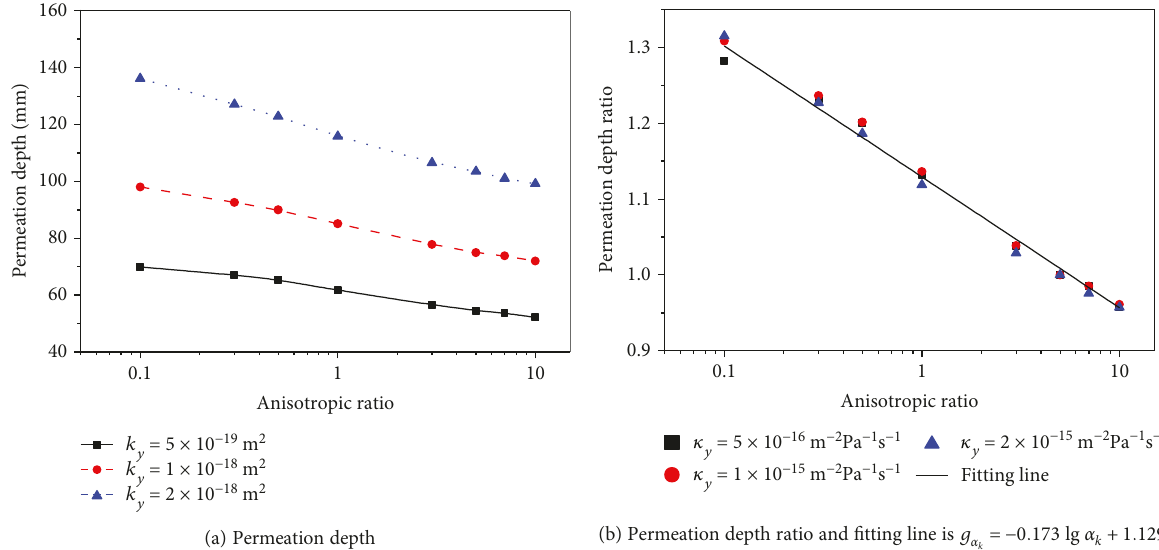
Figure 10: Changes of permeation depth and permeation depth ratio with permeability